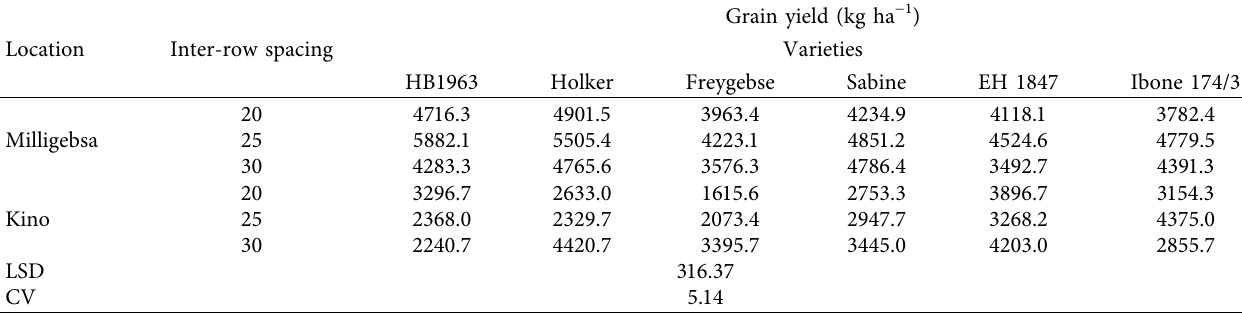
Table 8: Interaction effect of varieties, inter-row spacing, and location on grain yield of malt barley at Debark, north Gondar, Ethiopia, in 2019.